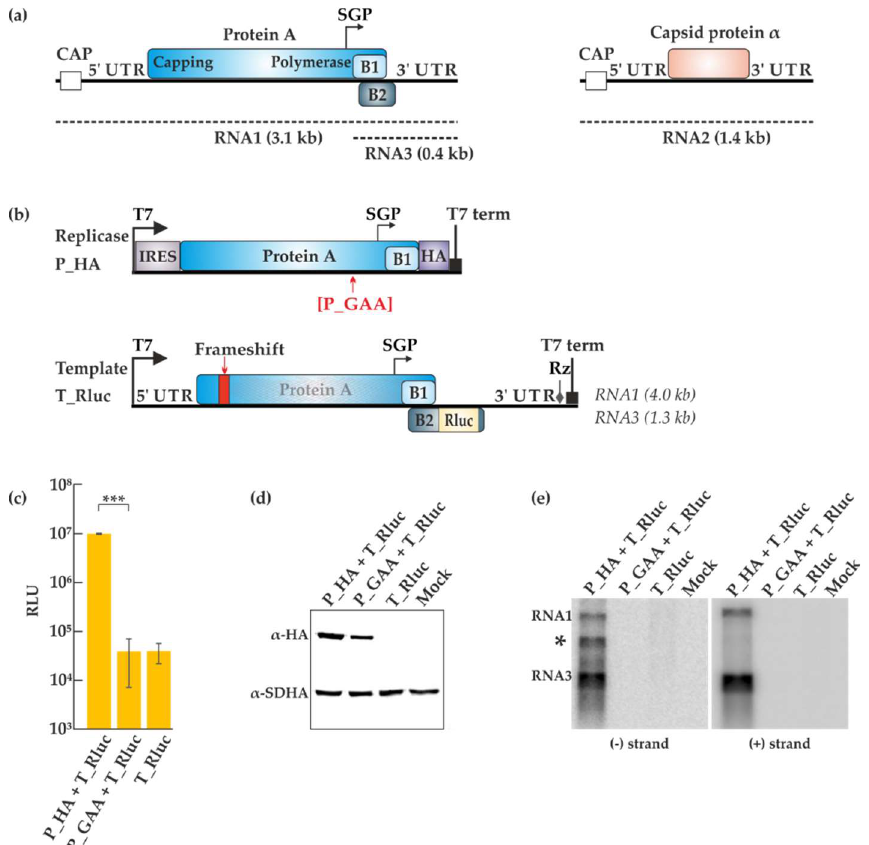
Figure 1. Trans-replication of flock house virus (FHV). ( a ) Depiction of the bipartite FHV genome. Both RNA1 and RNA2 are capped, positive sense RNAs flanked by untranslated regions (UTRs). The replicase protein A is translated from RNA1. The subgenomic RNA3 arises from the subgenomic promoter (SGP) and is used for the production of the small proteins B1 and B2. RNA2 codes for the capsid protein α. The dotted lines denote the complementary negative strands generated during replication. ( b ) The plasmids for the trans-replication system produce RNAs from the T7 polymerase promoter, ending with the T7 terminator (T7 term) and/or ribozyme (Rz) elements. The locations for the polymerase inactivating mutation and the frameshift mutation are shown in red. ( c ) BSR T7/5 cells were transfected with the indicated plasmids and luciferase activity was measured 40 h post-transfection. Luciferase signals are shown as mean (corrected for mock transfected background) from two independent experiments. Error bars represent the standard deviation. *** designates p < 0.001 (Student’s t test). RLU: relative light units. ( d ) Replicase expression following transfections in BSR T7/5 cells was detected by Western blotting with anti-hemagglutinin (HA) antibodies. The expression of the cellular protein succinate dehydrogenase (SDHA) is shown as a control. ( e ) Viral RNA synthesis was analyzed by Northern blotting using probes designed to detect negative and positive strands RNAs. The asterisk marks an uncharacterized RNA product that was sometimes observed during minus strand detection. Rluc: Renilla luciferase